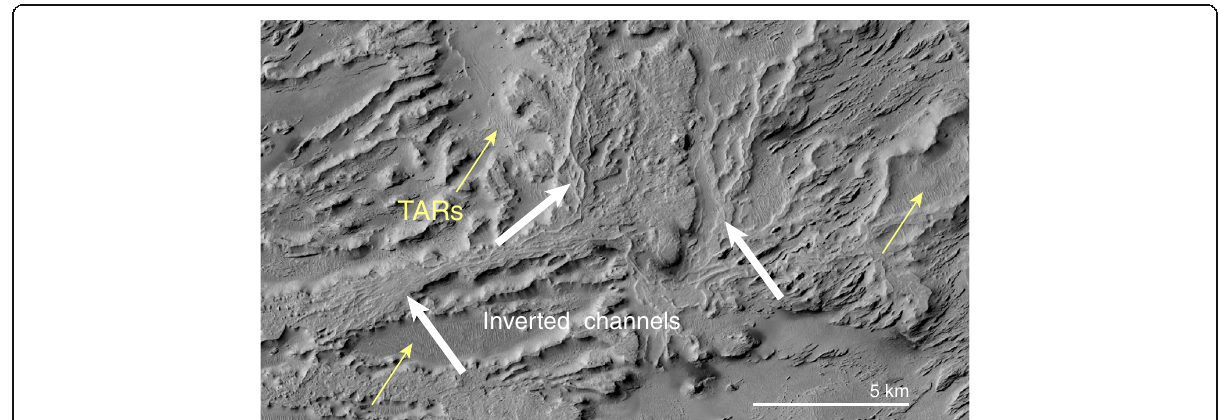
Fig. 9 Aeolis Mensae perspective, illustrating TARs and inverted